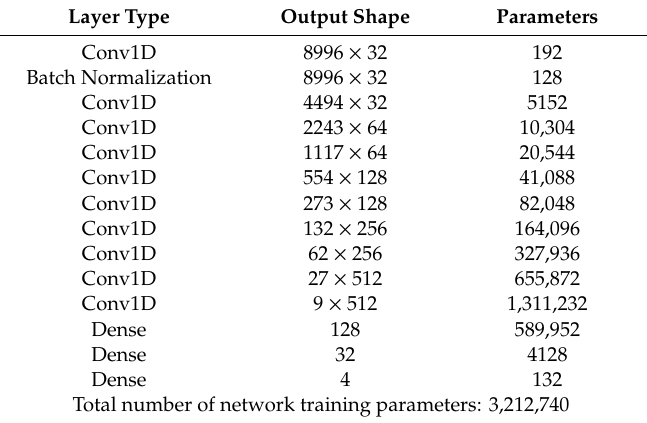
Table 7. Training parameters of the proposed 1D CNN.